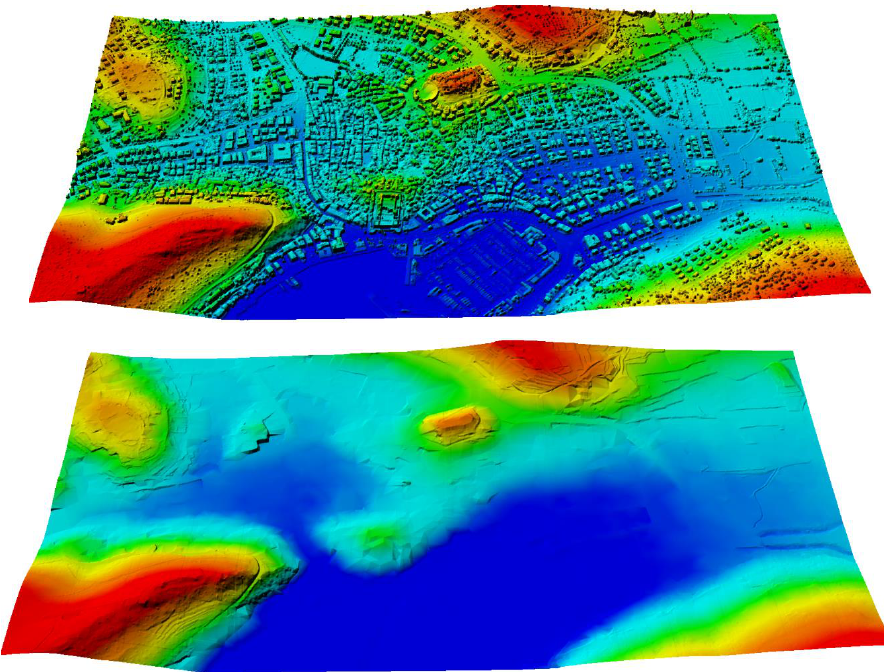
Figure 13. 25 cm resolution DSM and 1 m resolution DTM input for BuildingReconstruction software.